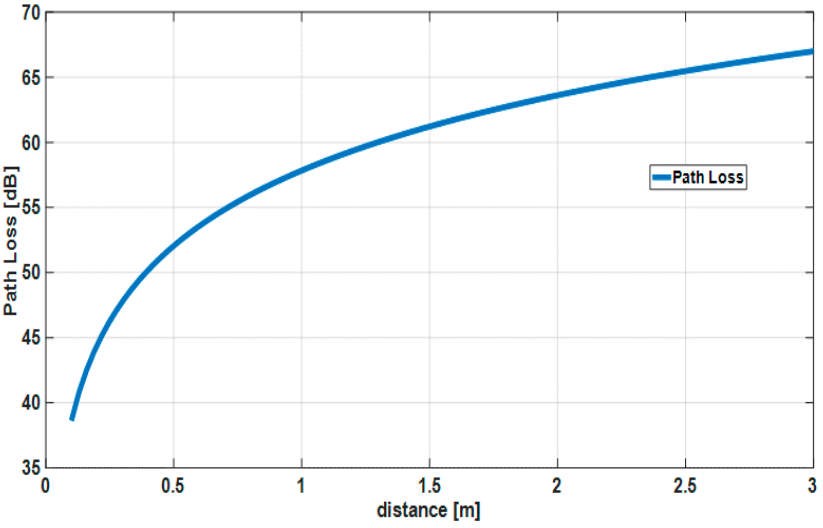
Figure 10. Average path loss in IEEE model CM3.